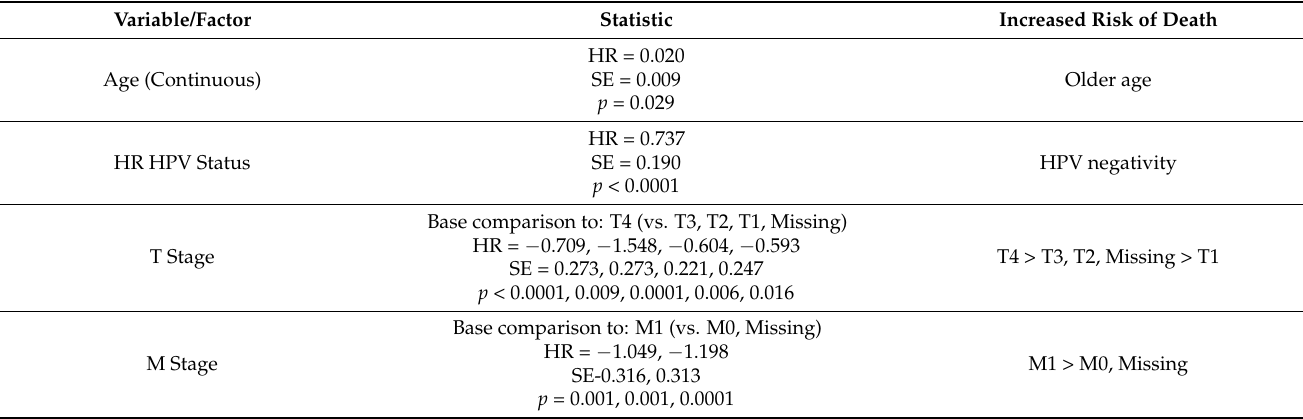
Table 6. Patient and tumor characteristics significantly predicting overall survival amongst oropha- ryngeal cancer patients by multivariable Cox proportional hazard model ( n = 189).